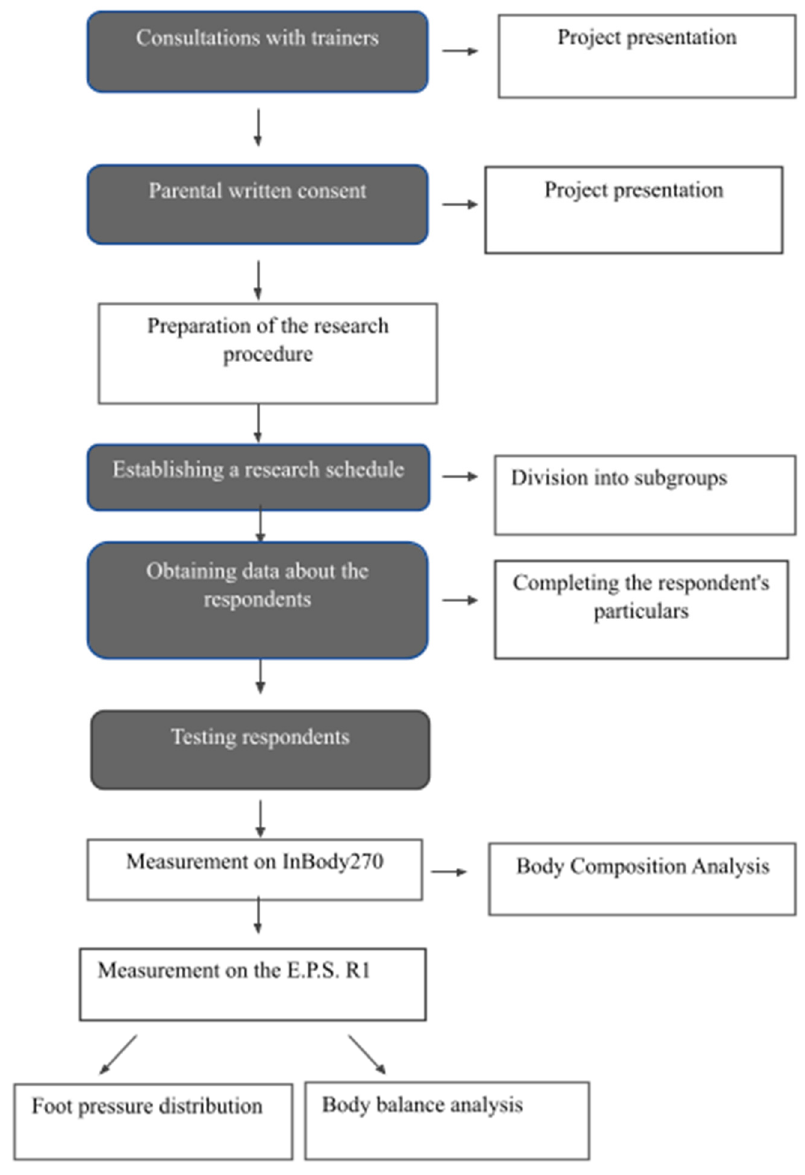
Figure 1. Scheme of the test procedure.